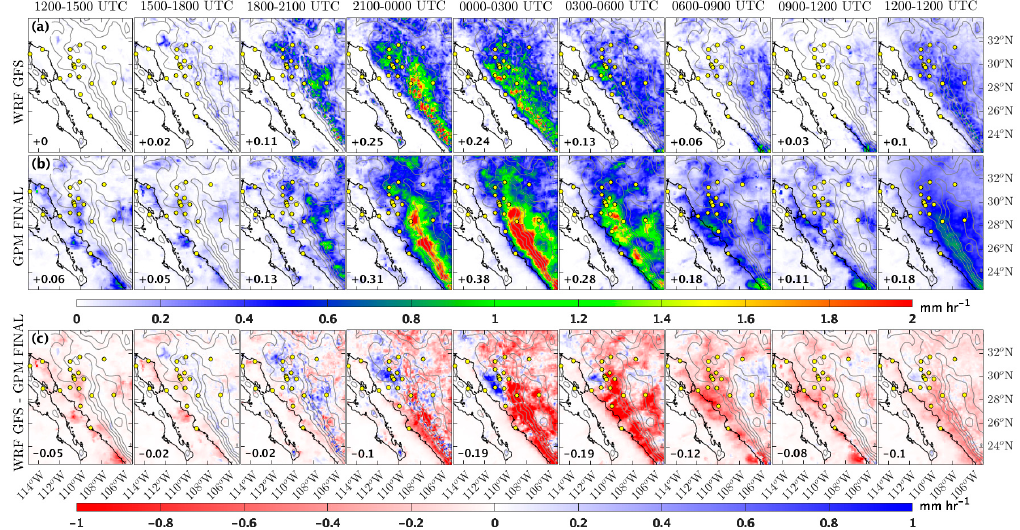
Figure 5. Mean hourly precipitation rate of WRF-GFS simulations ( a ), GPM Final precipitation products (b), and model bias ( c ) defined as WRF-GFS minus GPM Final, for combined strongly and weakly forced days within 3-hourly intervals (column 1–8) and 24-hourly intervals (column 9), are displayed. Yellow circles are observation sites of GPS Hydromet 2017. Mean values of precipitation rate across grid points ( a and b ) and biases ( c ) are given in the left corner of each panel. Red (blue) indicates dry (wet) model bias.